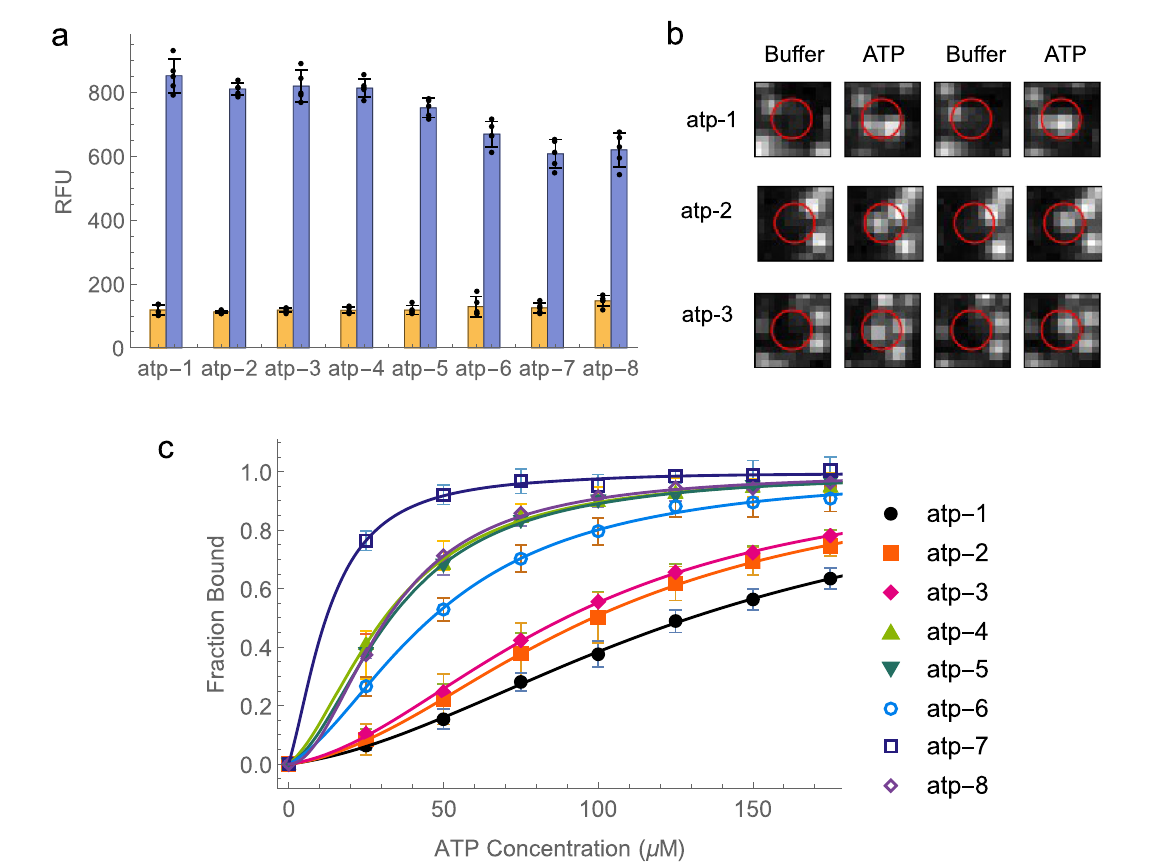
Fig. 3 | Identi fi cation and characterization of ATP aptamer switches. a Results from the high-throughput screen of switching domains for the ATP aptamer. Orange and blue bars respectively represent the cluster intensity in buffer and 500 μ M ATP. Data are presented as mean values ( n =5 replicates) and error bars represent the standard deviation of the measurements. Individual data points are overlayed asblackdots.Sourcedataareprovided asaSourceData fi le. b Extracted imagesofindividualATP-responsiveADSclusters(redcircle)ontheMiSeq fl ow-cell from multiple buffer and ATP cycles. c Validation of selected ADS constructs